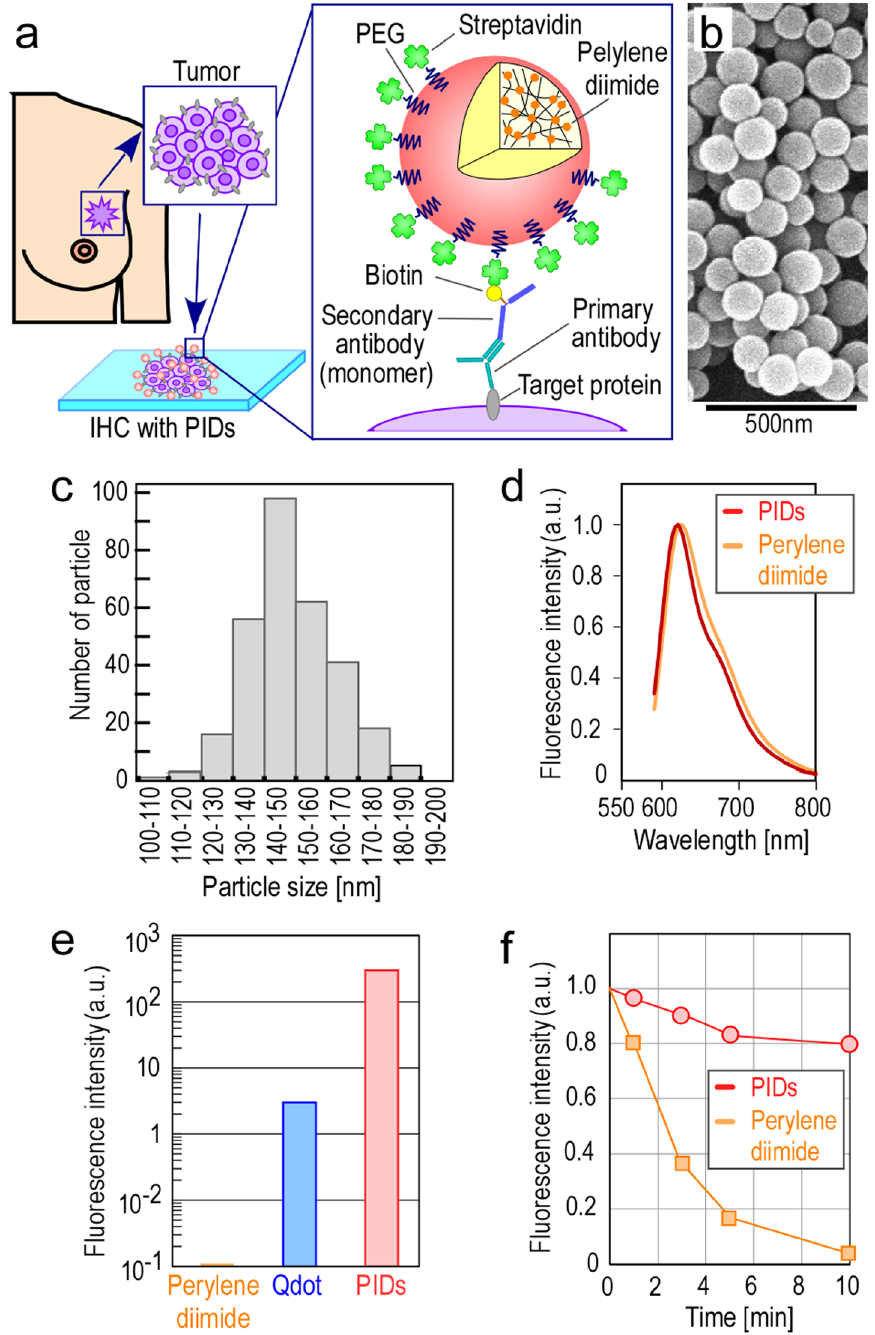
Figure 1. PID properties. ( a ) Schematic for the PID imaging of cancer tissues. We aimed to develop IHC with PIDs and measure the expression level of the target protein in cancer tissues with high accuracy. This schematic illustrates the histopathological diagnosis of breast cancer tissues excised from patients. The target proteins in cancer tissues were immunostained with a monoclonal primary antibody and a monoclonal secondary antibody that was monomerized and biotinylated, and then the samples were stained with PIDs coated with streptavidin by biotin-streptavidin binding. ( b ) SEM image of PID particles. Bar, 500 nm. ( c ) Distribution of PID particle sizes measured using SEM images. The average size was 149 nm (variation coefficient, 9%). ( d ) Fluorescence spectral patterns of the perylene diimide (orange line) and PID particles (red line). Both fluorescent materials were excited with a 580 nm laser and analyzed. ( e ) Comparison of 580 nm light-excited fluorescence intensities of perylene diimide, Qdots (Qdot 625), and PIDs. Each fluorescence intensity is shown on a logarithmic scale on the y -axis. ( f ) Comparison of the photostability of perylene diimide and PIDs. The perylene diimide or PIDs on the glass slide were irradiated by 580 nm light, and the fluorescence intensities of both fluorescent materials were measured over time. The fluorescence intensity of perylene diimide rapidly decreased to 2% over 10 min, whereas that of the PIDs remained at over 80% for the same irradiation